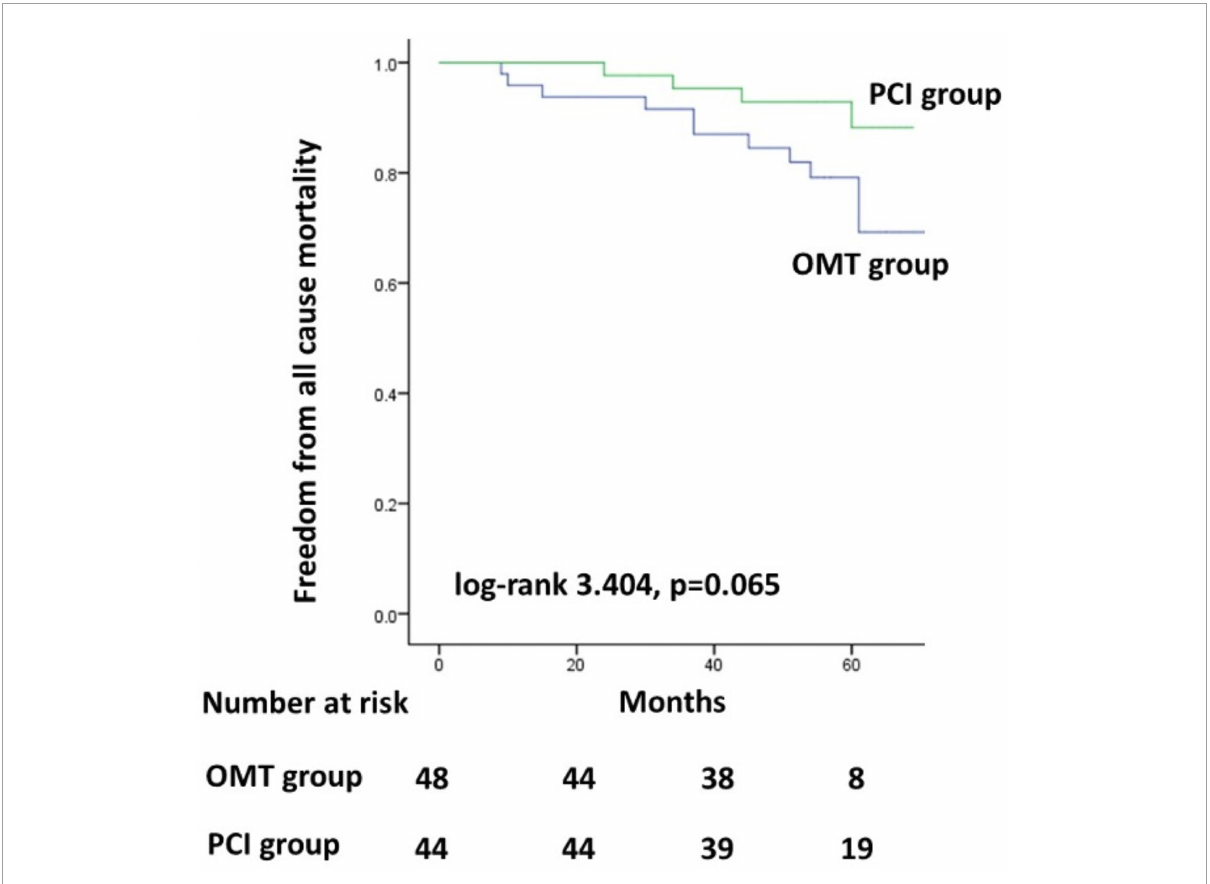
FIGURE2 Kaplan–Meier survival curves for all-cause mortality. PCI, percutaneous coronary intervention; OMT, optimal medical